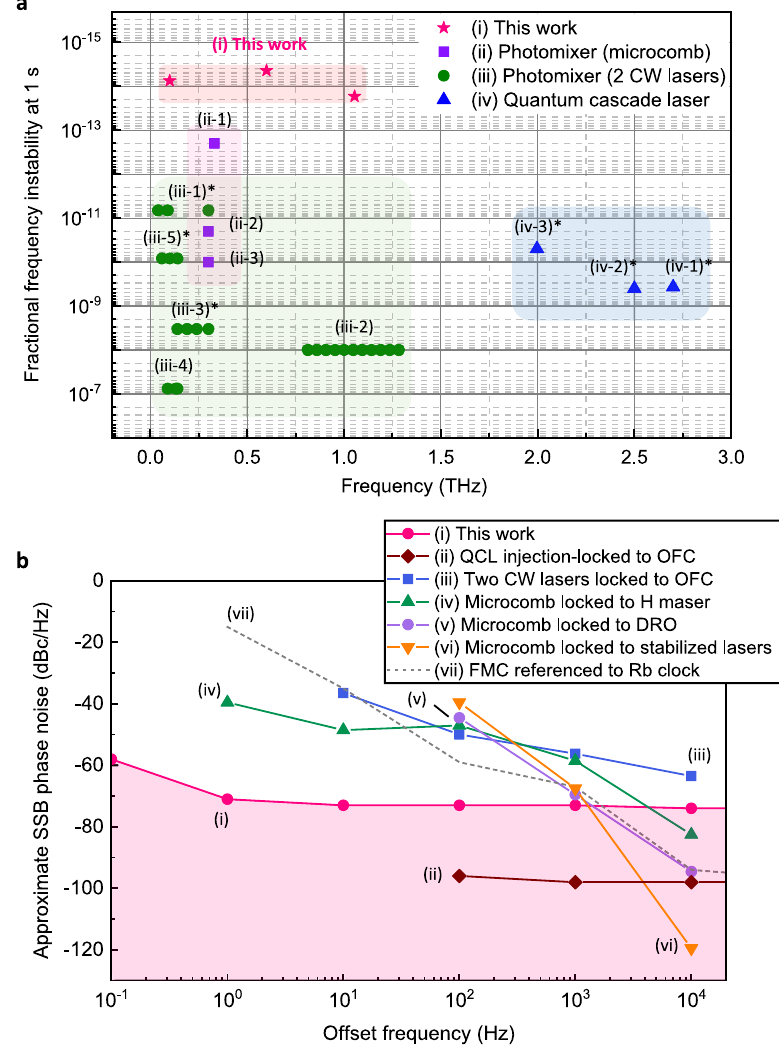
Fig. 5 | Performance comparison with state-of-the-art terahertz sources. a Frequency instability at 1s vs. operating frequency range; (i) this work, (ii- n ) microcomb-based photomixing ( n =1 – 3 refer to refs. 36 – 38 ), (iii- n ) heterodyne mix- ingofcwlasers( n =1 – 5refertorefs. 31 – 35 ),and(iv- n )QCLs( n =1 – 3refertorefs. 21 – 23 ). The fractional frequency instabilities marked with an asterisk are extracted from linewidth data (see “ Methods ” ). b Approximate single-sideband (SSB) phase noise; (i) this work, (ii) QCL injection-locked to a frequency comb (referenced to a